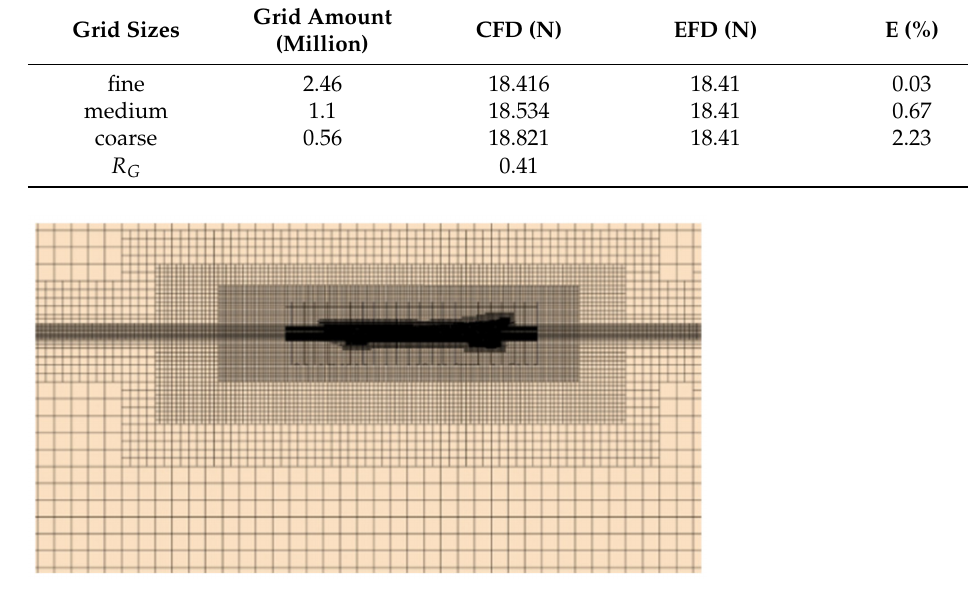
Figure 3. The grid